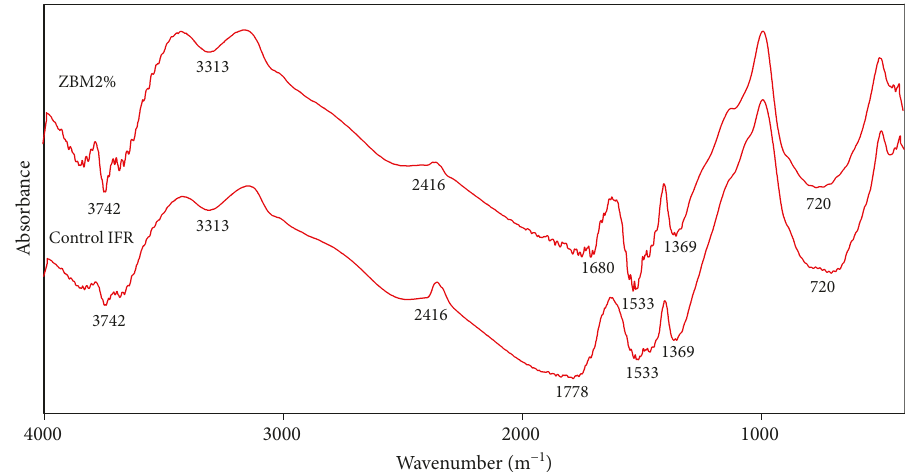
Figure 21: Fourier infrared curve of Control IFR and ZBM2%.